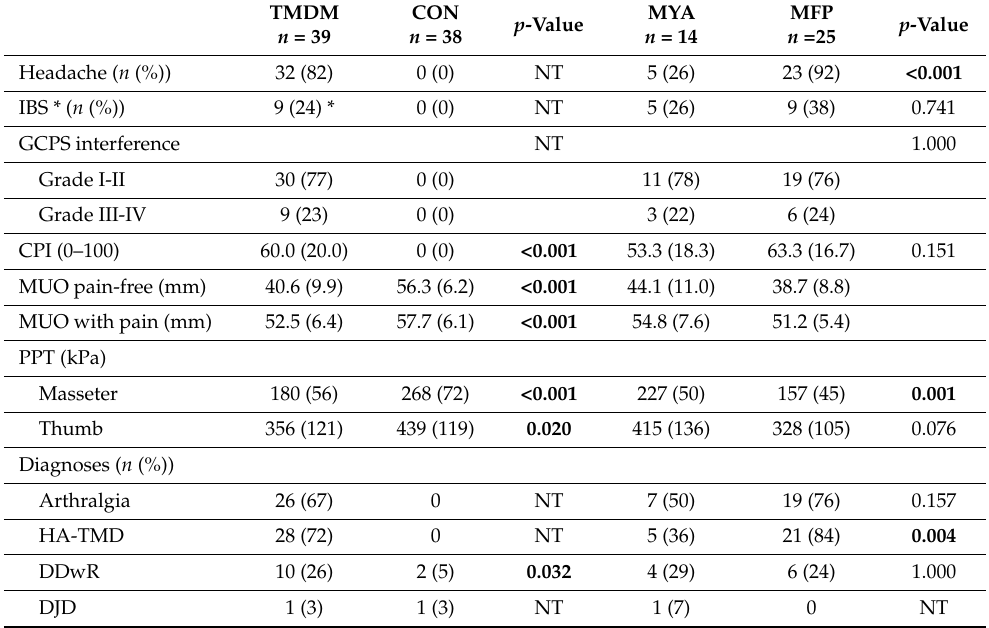
Table 2. Pain comorbidities, pain interference, clinical measures as well as other diagnoses in patients with myogenous temporomandibular disorders (TMDM) and pain-free controls (CON) as well as in TMD subgroups myalgia (MYA) and myofascial pain (MFP). Data show median (IQR) unless other is